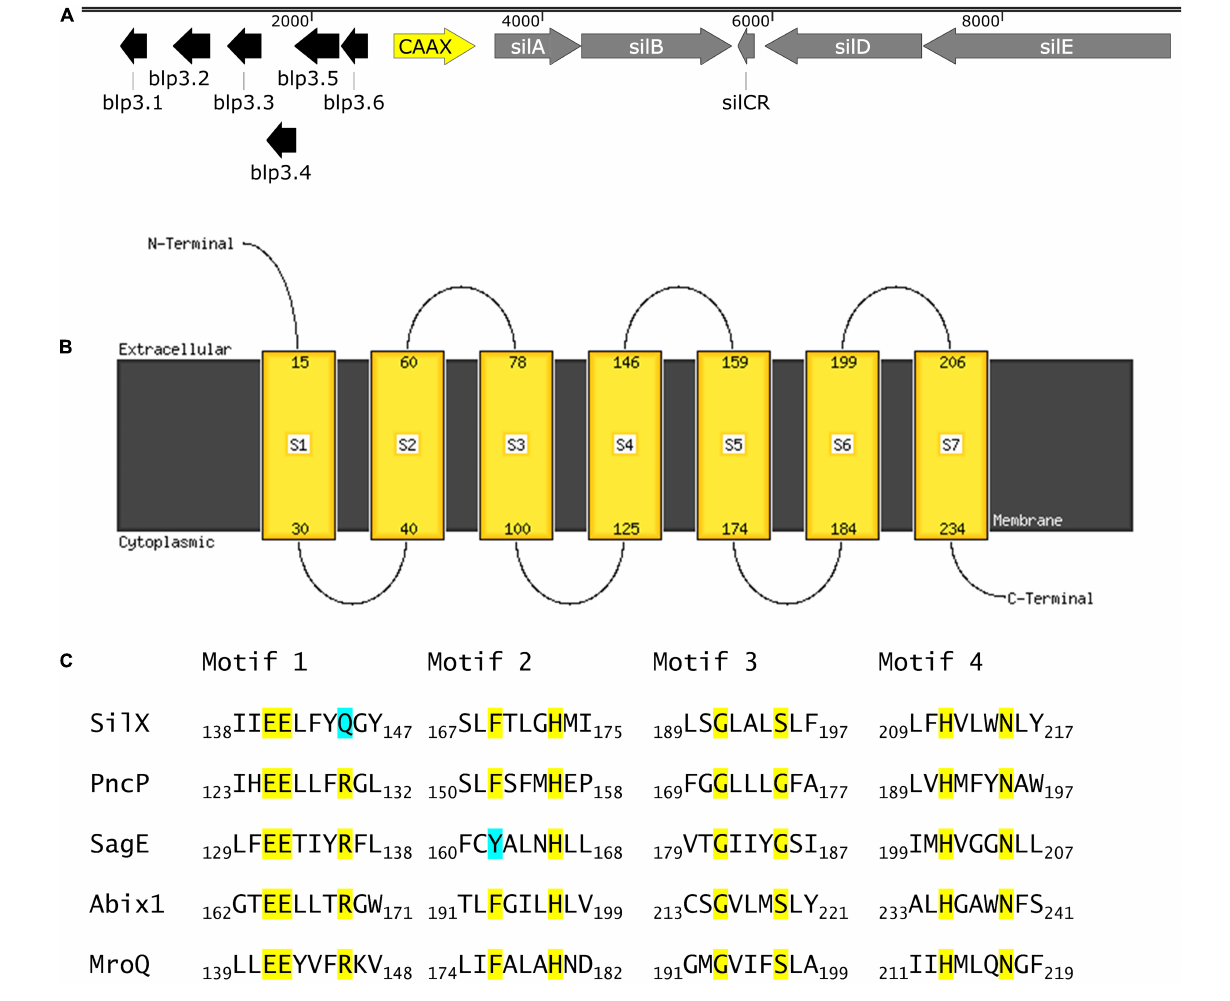
FIGURE 1 | SilX is a transmembrane protein harboring conserved CAAX domains. (A) Genetic organization of the bacteriocin and quorum sensing locus in S. anginosus BSU 1211 (Accession: MZ766502). Modified from Vogel et al. (2021). (B) Prediction of protein transmembrane structure of SilX constructed using Phyre2. (C) SilX is a member of the CAAX proteins. Conserved domains of CAAX proteins are depicted with the important residues marked in yellow and differing residues marked in turquoise. SilX is compared to PncP of Streptococcus mitis (Acsession number: VTS34806.1), SagE of S. pyogenes (Accession number: QJC39319.1), Abix1 of Streptococcus agalactiae (Accession number: WP_001042316.1) and MroQ of S. aureus (Accession number: